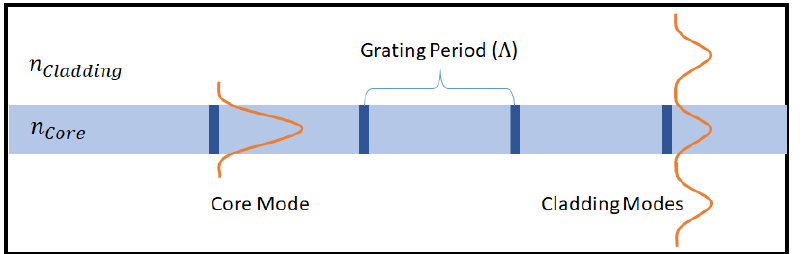
Figure 1. Section of the refractive index profile and transmitted modes of an LPFG inscribed in standard single-mode optical fiber; the depicted cladding modes leak out of the fiber.